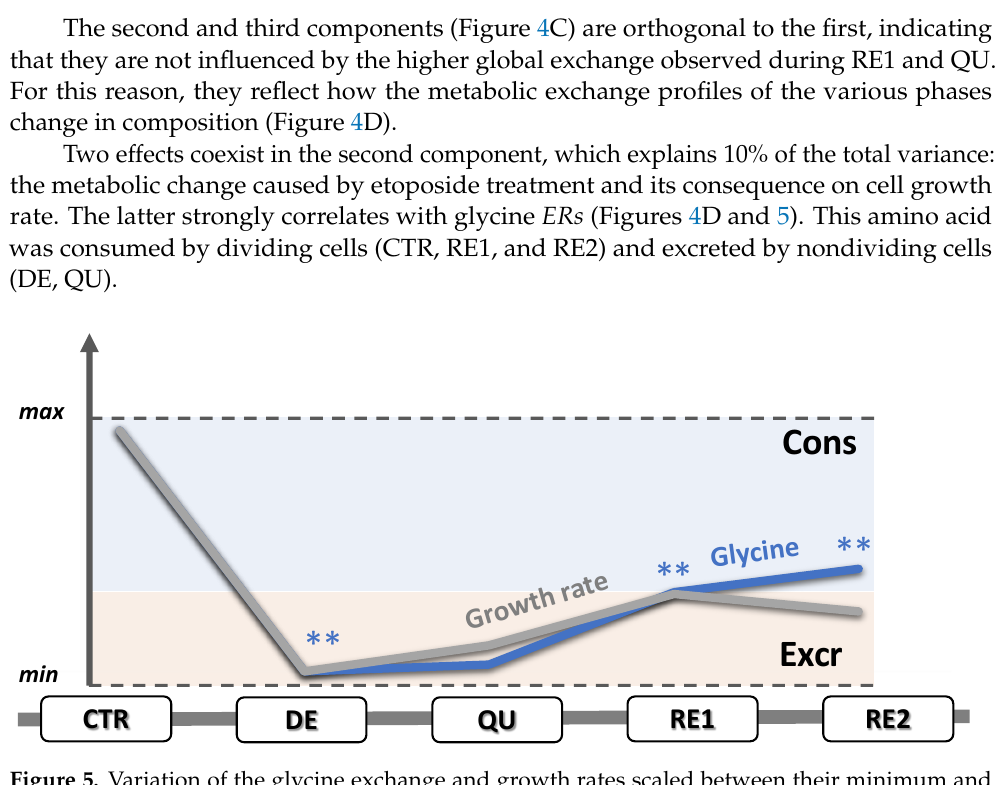
Figure 5. Variation of the glycine exchange and growth rates scaled between their minimum and maximum values. Within the blue and orange areas fall the phases that consume (Cons) or excrete (Excr) glycine. Significant differences with respect to the previous phase are indicated with ** for p <